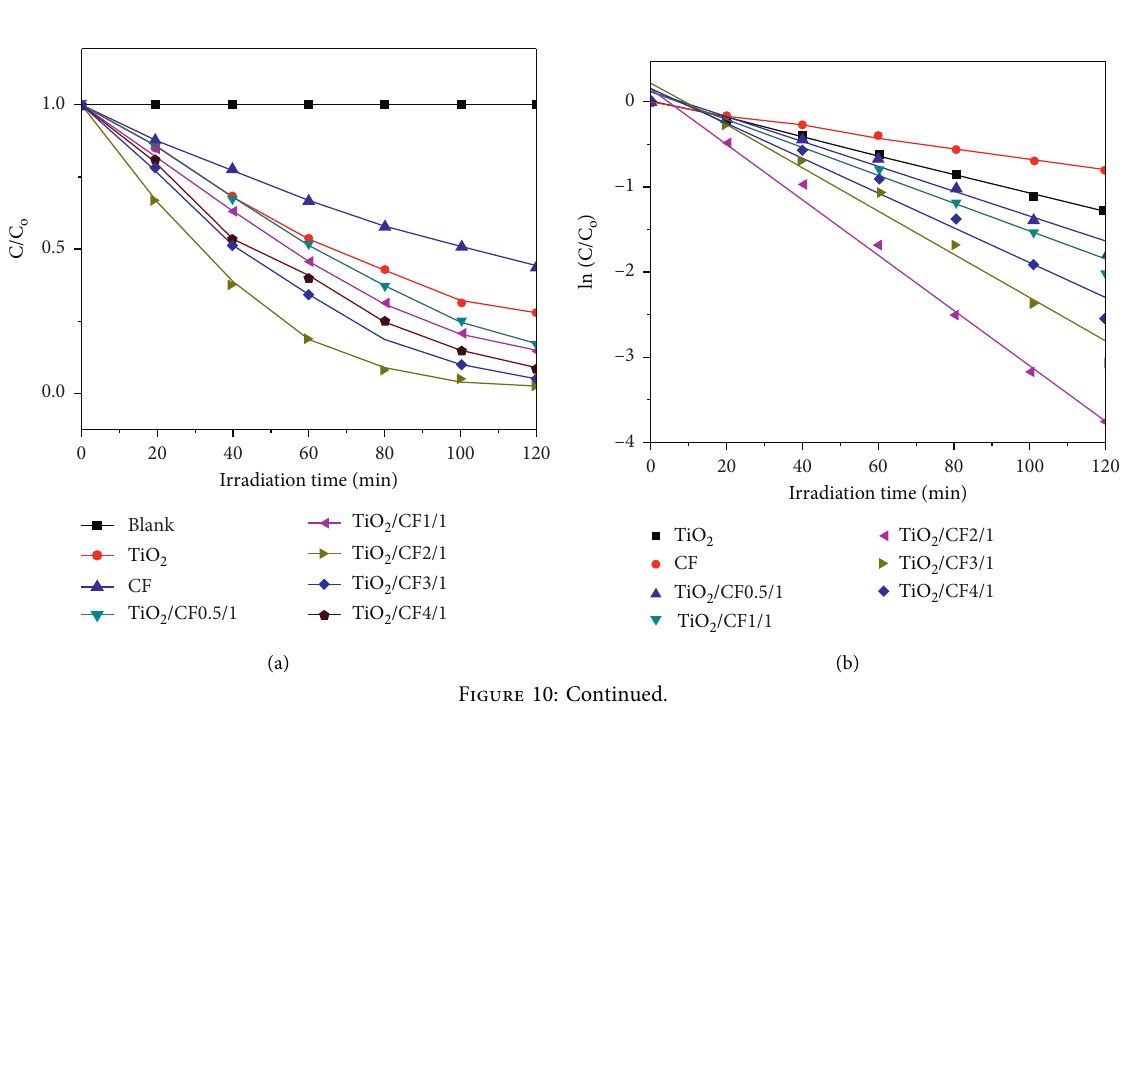
2 and (b) TiO 2 /CF2/1.